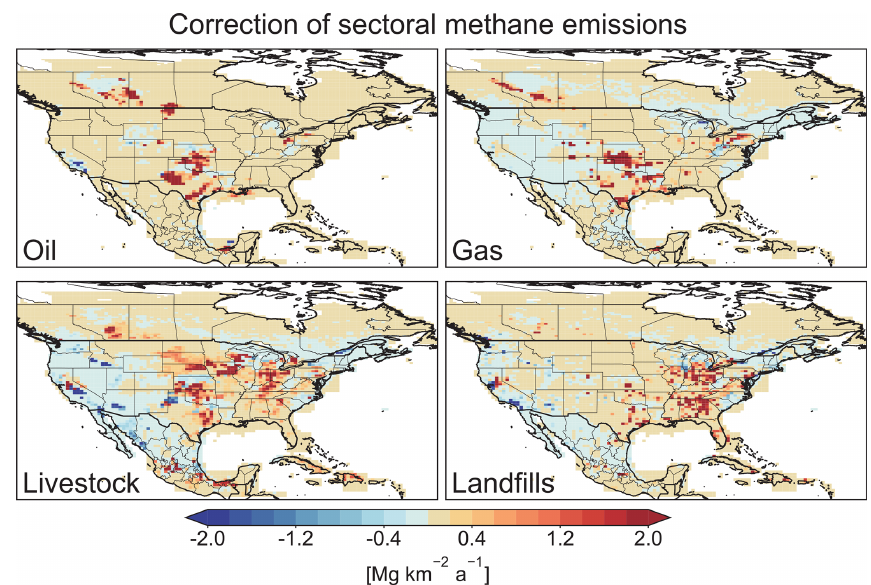
Figure 8. Posterior correction for mean 2010–2017 methane emissions from the oil, gas, livestock, and landfill sectors as given by the base inversion. The correction factors for anthropogenic emissions are relative to the national emission inventories used as prior estimates (EPA GHGI for the US, ECCC NIR for Canada, INECC for